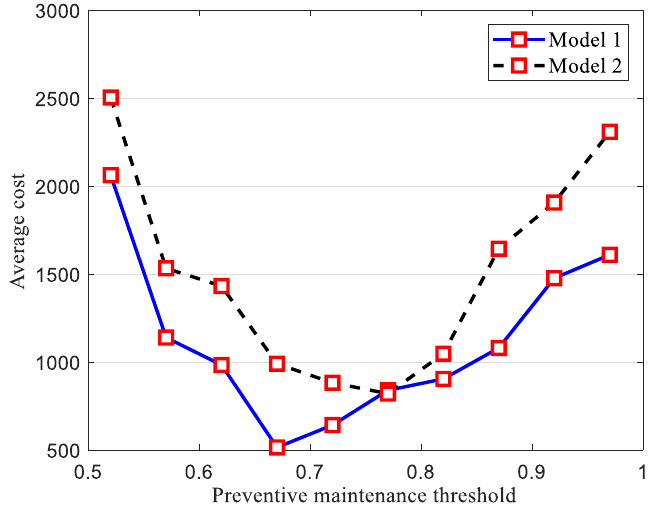
Figure 12. Comparison of average cost of two models .